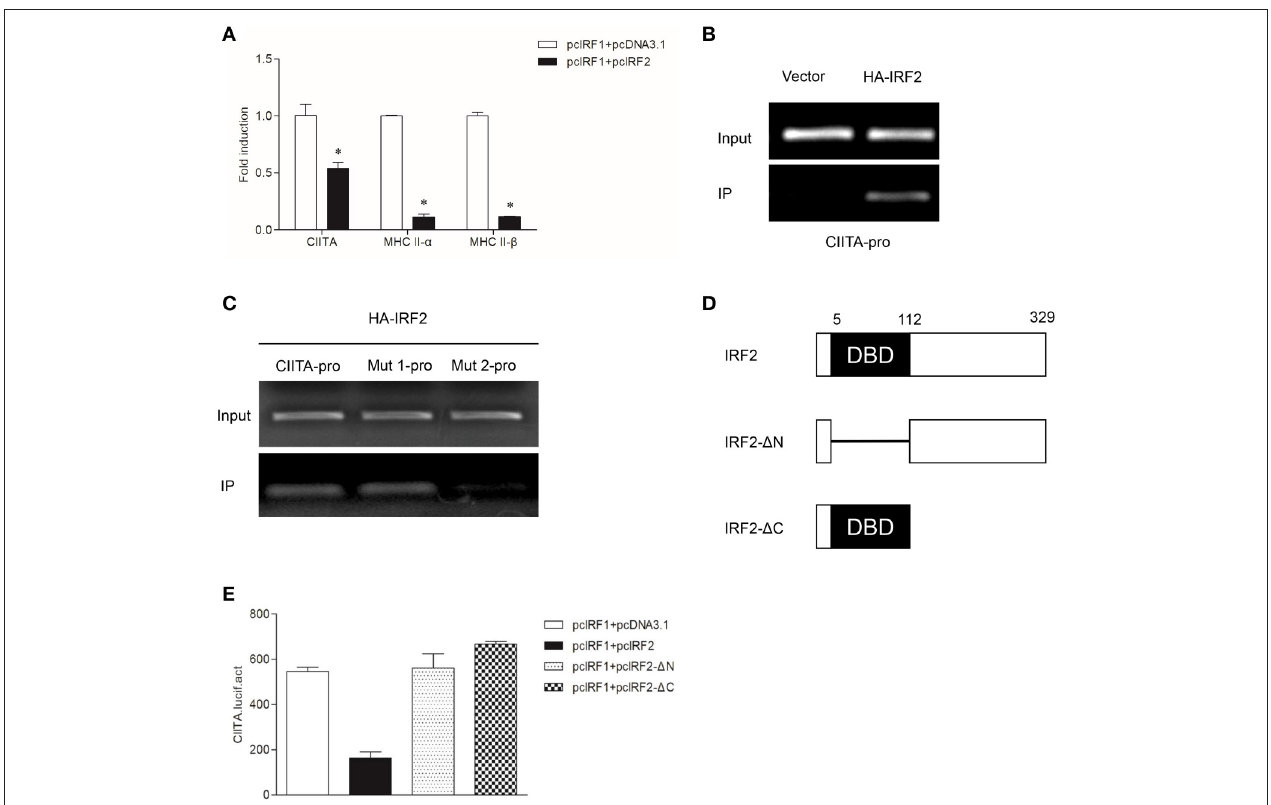
FIGURE 6 | Suppression of CIITA and MHC II expression by IRF2. (A) Activation of CIITA and MHC II induced by IRF1 can be suppressed by IRF2. GCO cells seeded in 6-well plate overnight were cotransfected with (pcDNA3.1 or pcIRF2) and pcIRF1. Fold changes of the gene expression were measured through qRT-PCR. Asterisks (*) indicate significant differences from control ( p < 0.05). (B,C) The binding of IRF2 with CIITA promoter. The cells seeded in 10-cm dishes were cotransfected with (5 µ g PCMV-HA, or HA-IRF2) and (5 µ g CIITA-pro, Mut 1-pro, or Mut 2-pro). Cell samples were harvested at 24h after transfection and cell lysates were immunoprecipitated with anti-HA-Agarose beads. The input was used as a control in semiquantitative PCR to quantify the DNA concentration. (D) Schematic representation of wild type IRF2 and its two mutants. (E) Effect of the two structural domains of IRF2 on the CIITA promoter. GCO cells were cotransfected with (IRF2, IRF2- 1 N, or IRF2- 1 C) and CIITA promoter, luciferase activities were monitored at 24h after